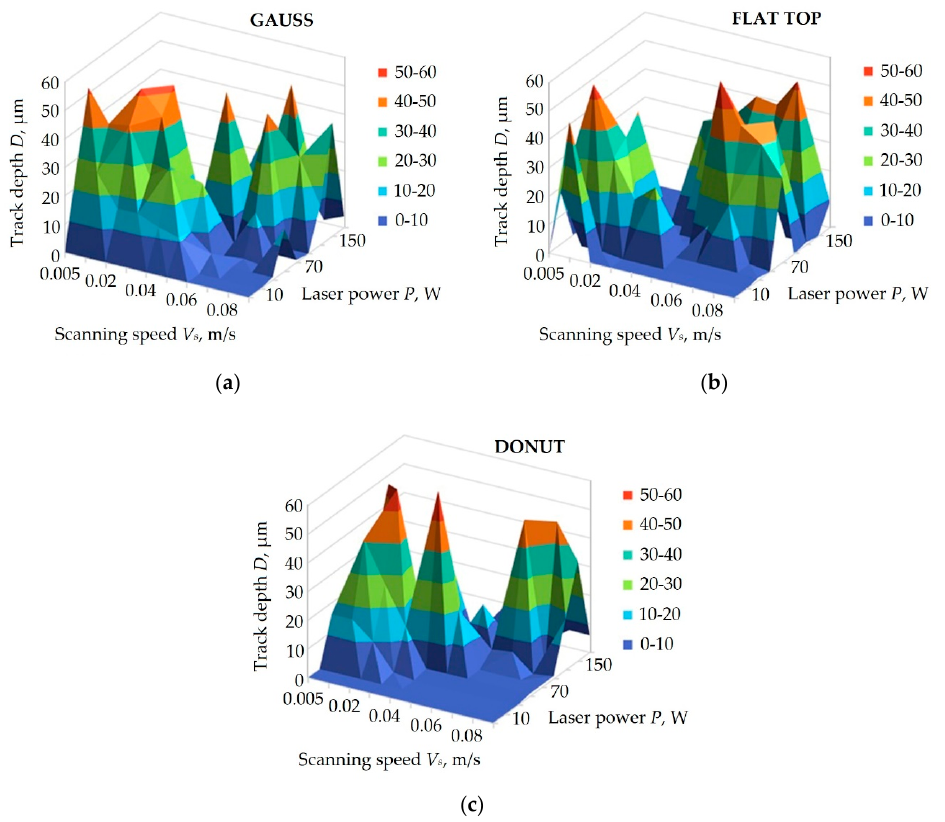
Figure 15. Dependence of the track depth on SLM parameters for CoCrMo powder for values less than 60 ± 5 µm: ( a ) Gauss; ( b ) flat top; ( c ) donut. 60 ± 5 µ m: ( a ) Gauss; ( b ) flat top; ( c )